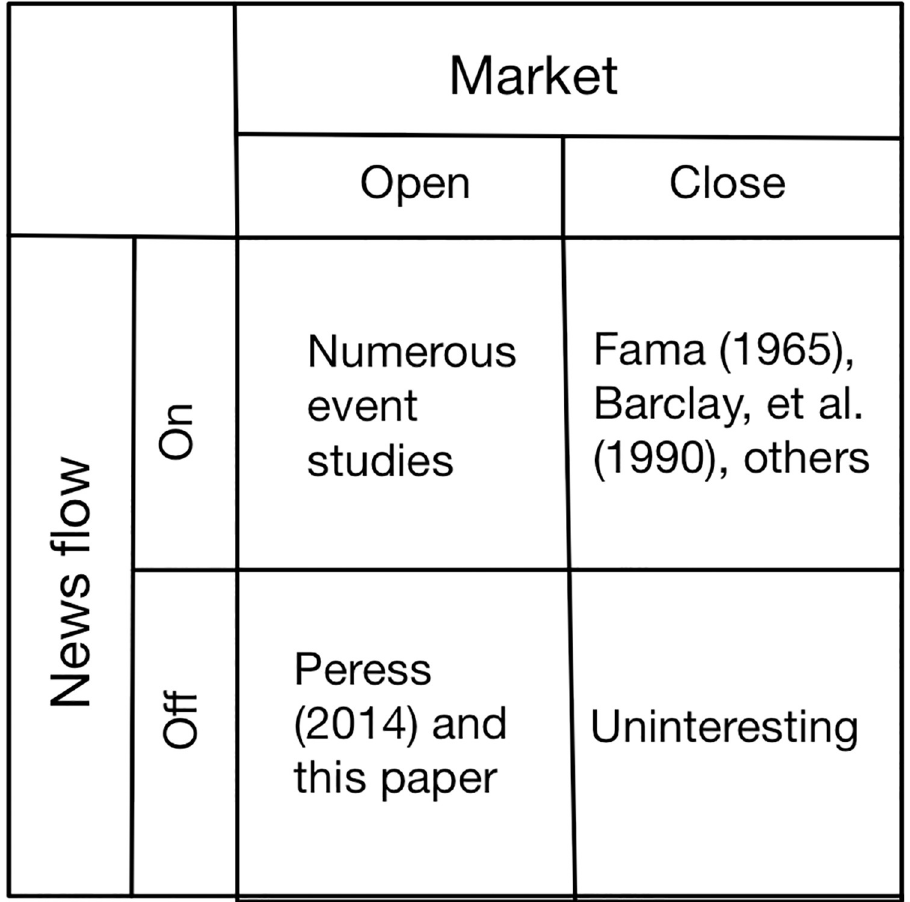
Fig 1. Gap filled by this paper. The financial market can be open or closed. The free flow of news can be on or off. This creates four possible scenarios between the financial market and news flow. This figure captures the gap in the literature that this paper